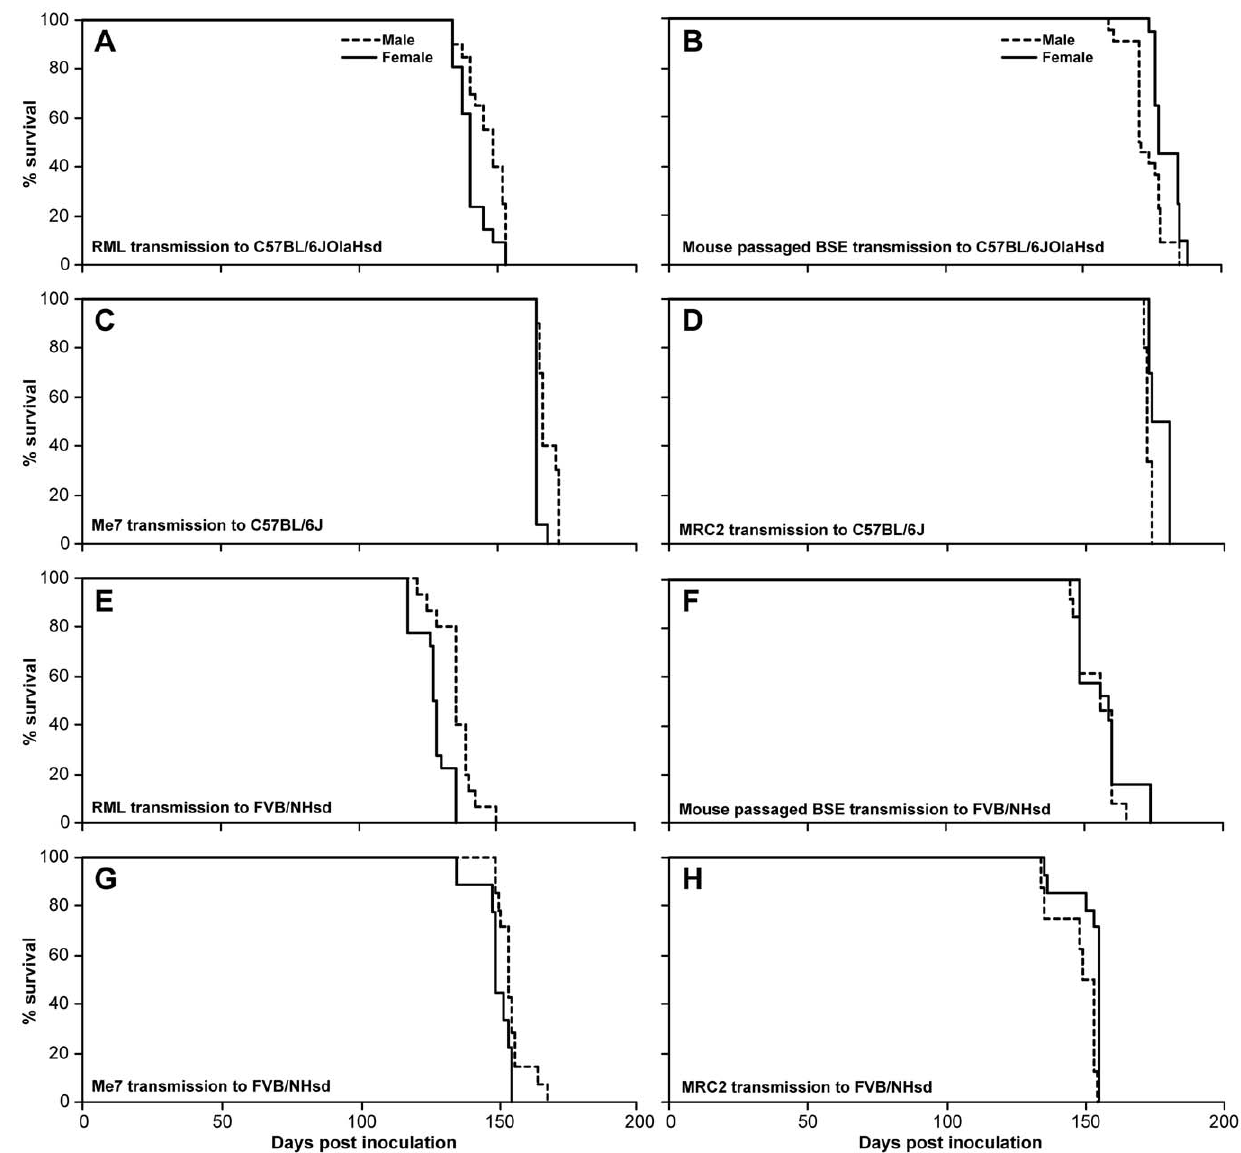
Figure 1. C57BL/6 and FVB/N survival curves. Survivalcurves for priontransmissions toC57BL/6J(A–D)and FVB/NHsd(E–H) mice. Aand E, Chandler/ RML prions; B and F, mouse passaged BSE prions; C and G, ME7 prions; D and H, MRC2 prions. % survival is shown on the y-axis and days post inoculation is shown on the x-axis. All data are significant (P , 0.05) except for mouse-passaged BSE transmission to FVB/NHsd. Detailed values are given in Table 1.